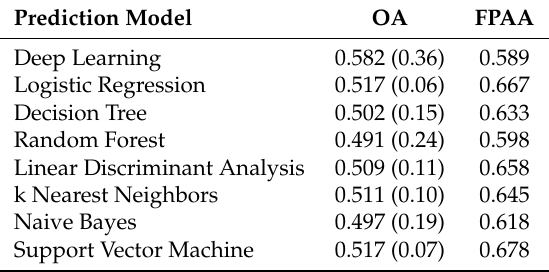
Table 3. Prediction accuracy for various machine learning models. We report the overall accuracy (OA) and FPAA. The training sample is of size N = 5000, with a lookback period of L = 30 days and forecast period of F = 10 days. We also report how far from the threshold of 0.527 (in standard deviations) the OA is, shown in parenthesis next to the OA value. In no case, is the predictive power